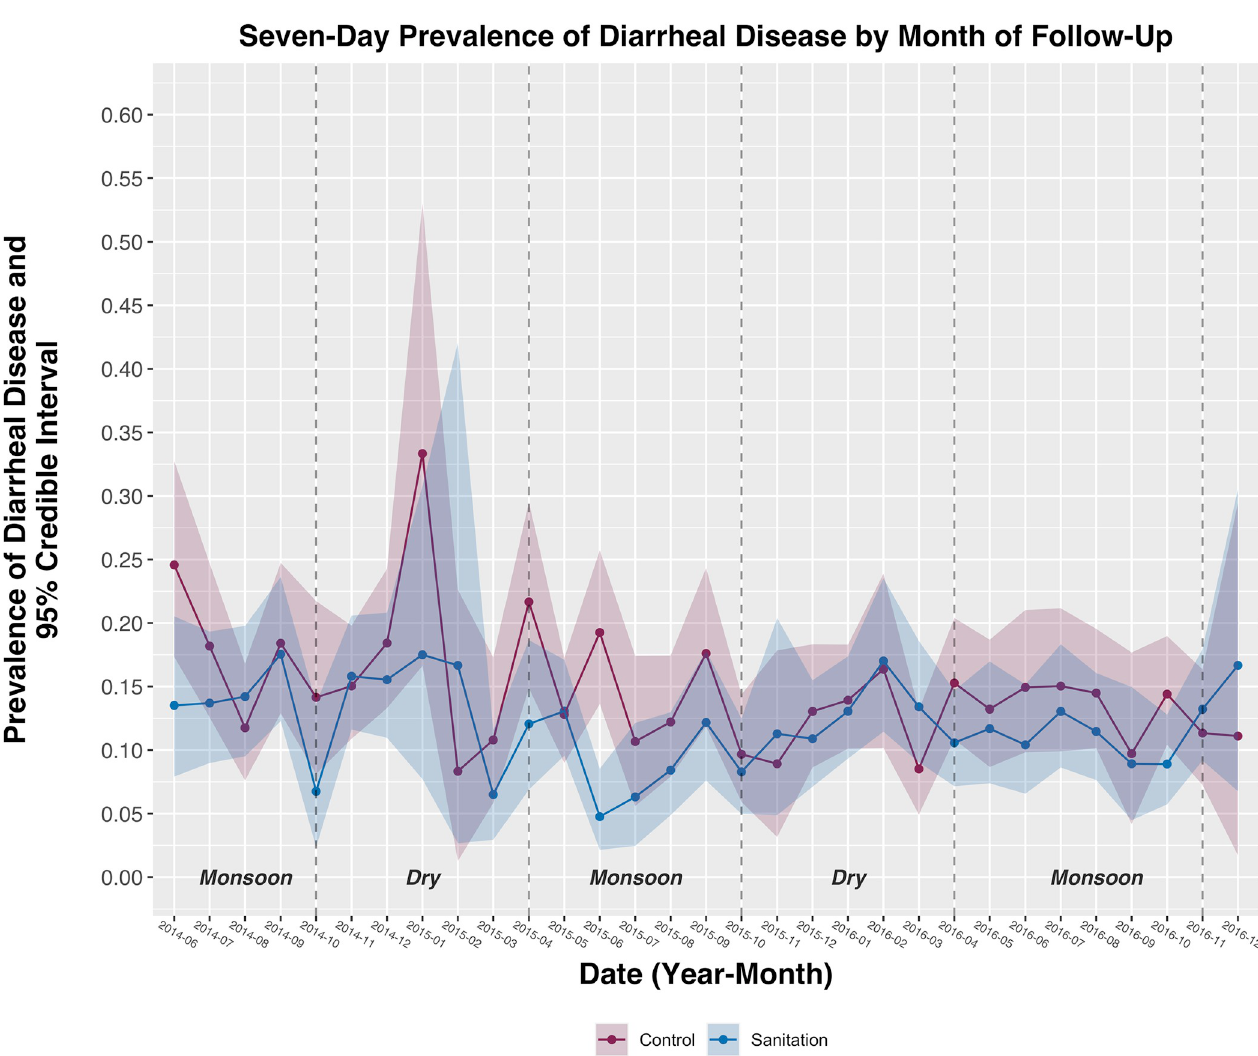
Fig 2. Prevalence of diarrheal disease among children under 5 years by intervention arm and month of follow-up. Shaded bands represent 95% credible intervals around each prevalence estimate. Monsoon and dry seasons are indicated with vertical dashed lines.